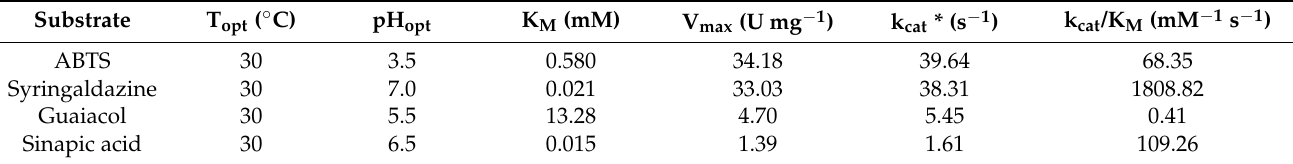
Table 3. Kinetic parameters for purified recombinant laccase